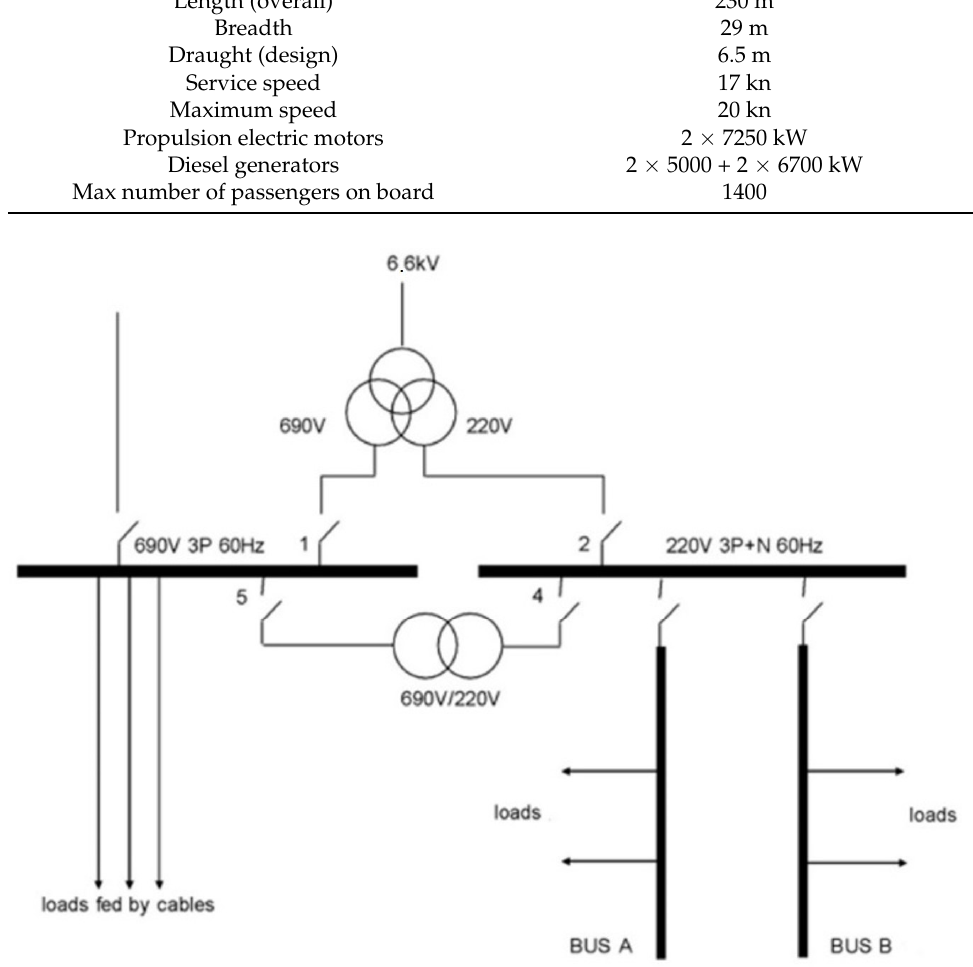
Figure 1. Original LV distribution scheme downstream of a substation transformer supplying hotel loads.